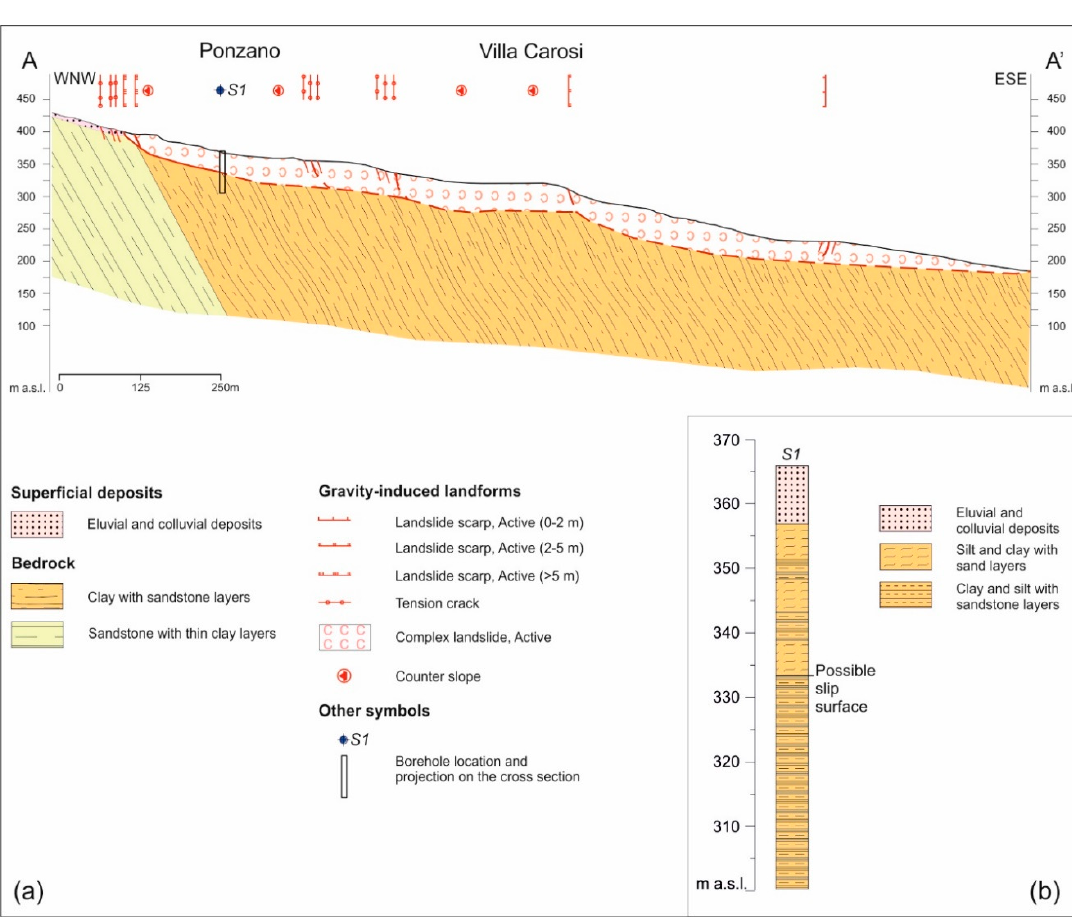
Figure 9. ( a ) Geological and geomorphological cross-section of the Ponzano area (location in Figure 8). ( b ) Stratigraphy of the borehole S1 (location in Figure 8).